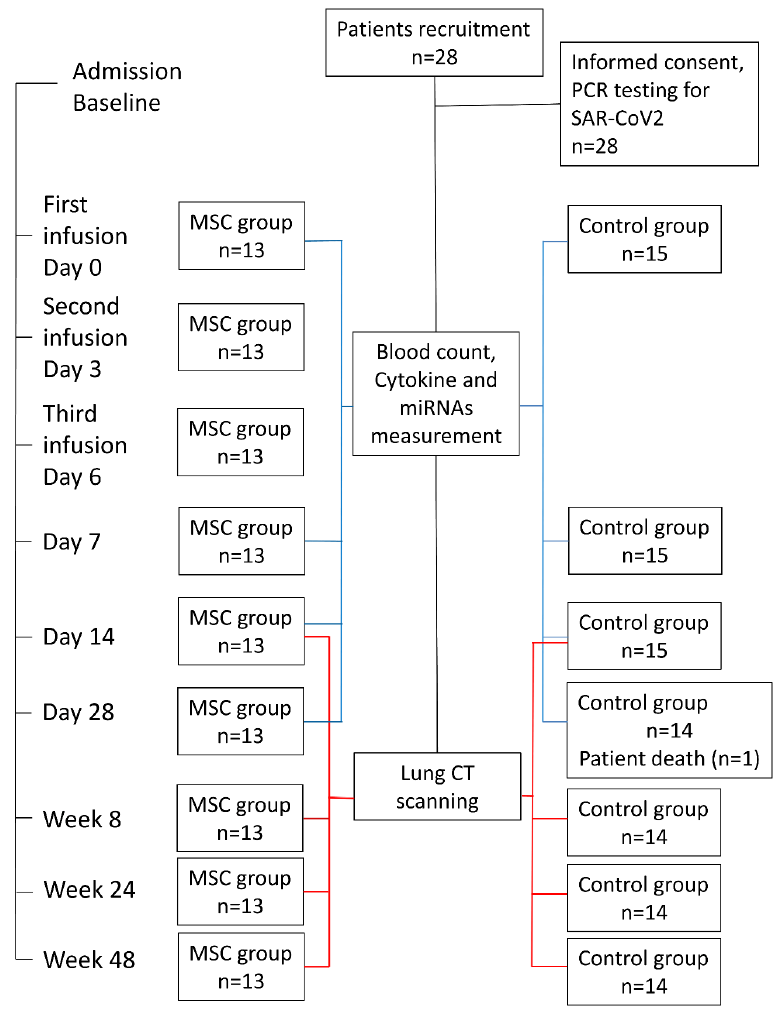
Figure 8. Flow chart for patient enrollment, intervention, and follow-up.